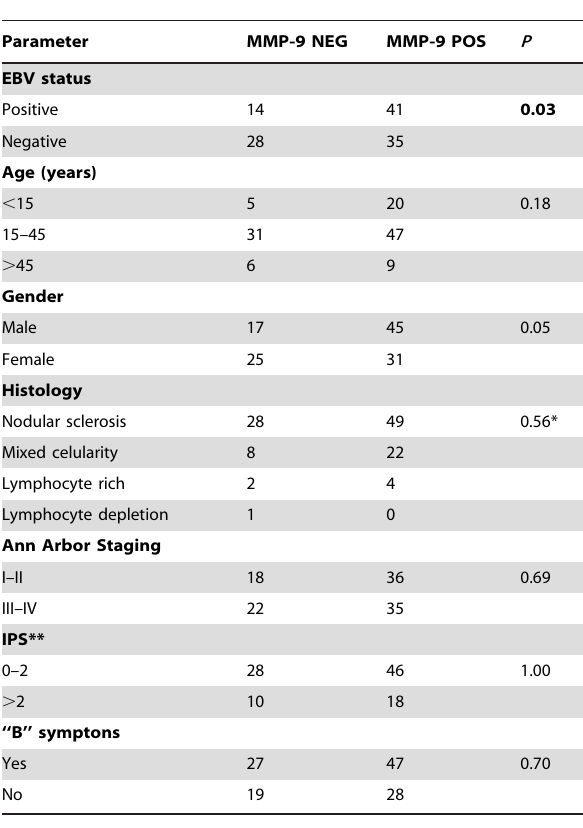
POS - positive; NEG - negative. Fisher’s exact test or Qui-square test. (*) For statistical purposes, the categories ‘‘lymphocyte rich’’ and ‘‘lymphocyte depleted’’ have been grouped together; (**) data reported only for